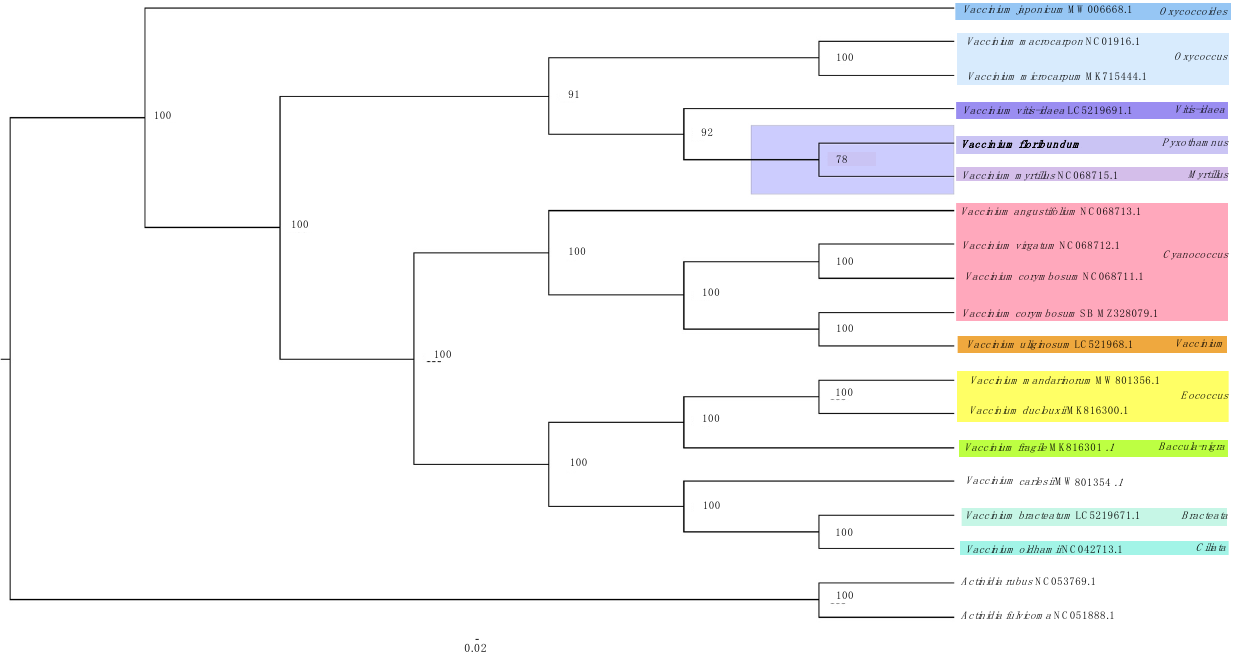
Figure 7. Phylogenetic tree constructed with 87 genes of 17 Vaccinium species cp genomes including the V. floribundum cp genome using RAxML. Branch labels indicate the BS values (%). The scale bar represents nucleotide substitutions per site. Two sequences of Actinidia genus ( A. rubus and A. fulvicoma ) were used as an outgroup to root the tree. Sections of Vaccinium are represented by different colors.